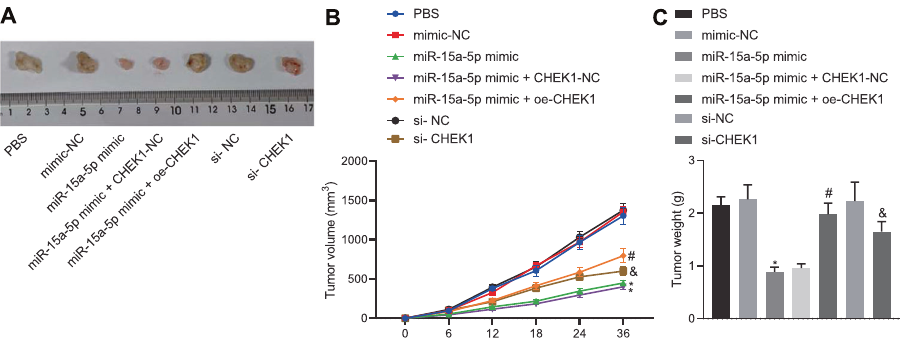
Fig. 5 miR-15a-5p retards the tumorigenesis by inhibiting CHEK1 expression in vivo. A Images of the removed xenograft tumors. B Dynamic volume curve of xenograft tumors in vivo. C Weight of the removed xenograft tumors. In panels A – C , HuCCT1 cells treated by miR- 15a-5p mimic, miR-15a-5p mimic + oe-CHEK1, si-CHEK1, their corresponding controls and PBS were individually subcutaneously injected into nude mice to construct nude mouse models of xenografts. The data are presented as mean ± standard deviation. Comparison to